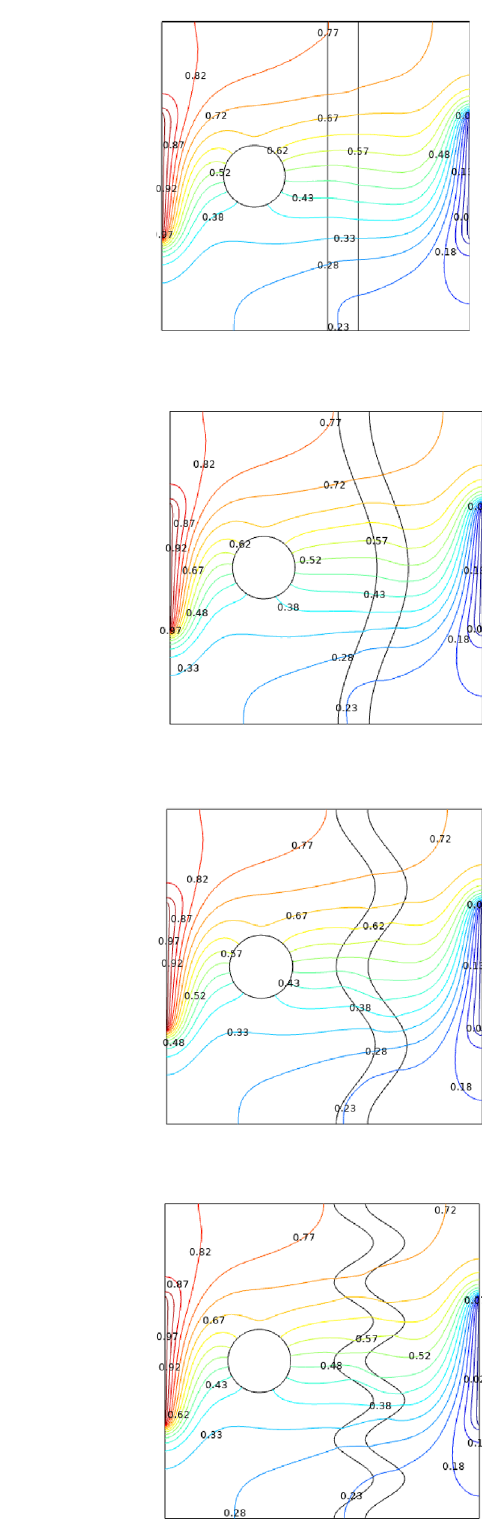
Figure 14. Variations of the streamlines (left), isotherms (right), with undulation N at, Ra 0.4 , Da 0.01 , φ 0.08 and ω ε = = =